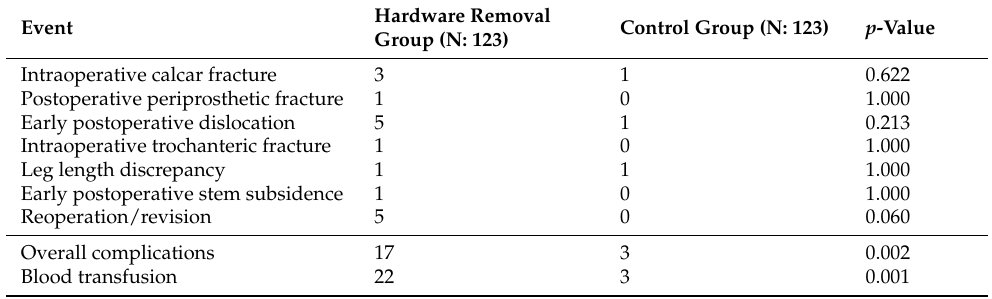
Table 3. Perioperative notable